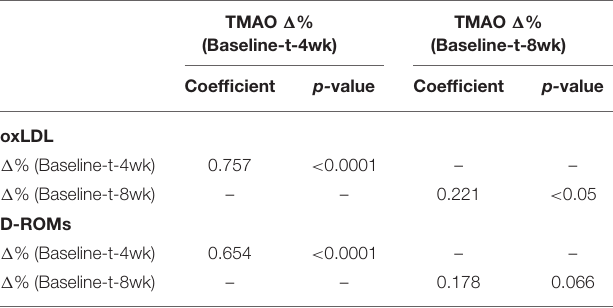
TABLE 7 | Correlation analysis between variations of TMAO, oxLDL, and D-ROMs serum levels in all study